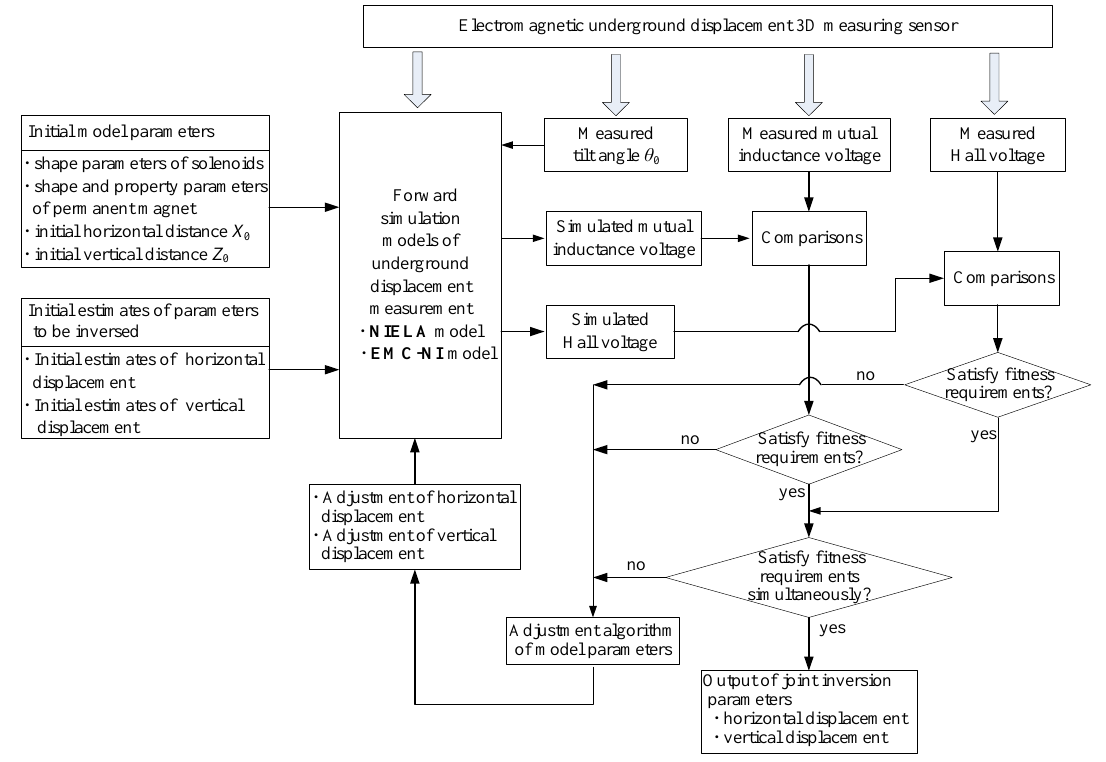
Figure 4. Schematic diagram of the displacement parameter joint inversion method. NIELA, numerical integration-based equivalent loop approach; EMC-NI, equivalent magnetic charge-numerical